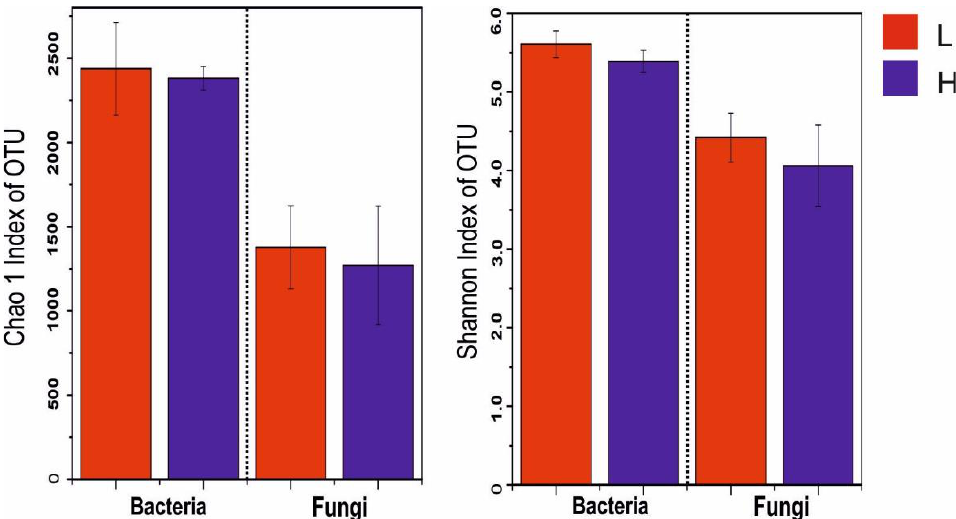
Figure 1. The OTUs based alpha-diversity (Chao1 (richness) and Shannon (diversity)) indices of soil bacterial and fungal communities at the low (L) and high (H) elevation forests in the study area of Wuyi